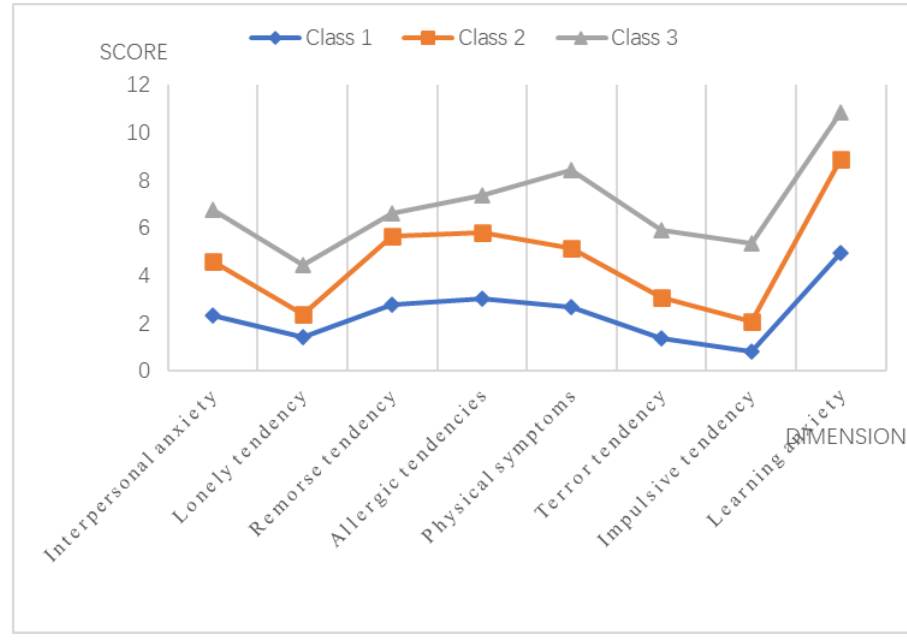
Figure 2. Depiction of the three latent classes defined by means on eight facets of anxiety among junior high school students in rural areas of Jiangxi